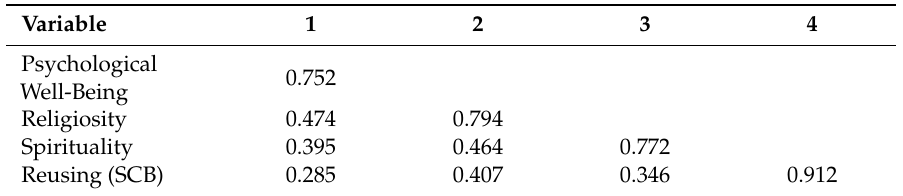
Table 3. Discriminant